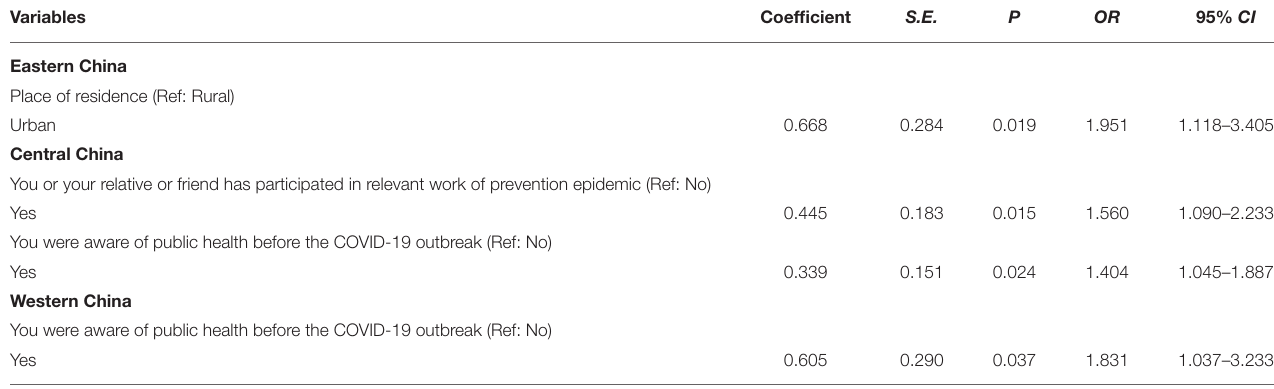
TABLE 4 | Stepwise Multivariate Logistic Regression Analysis on the Influencing Factors of Residents’ attitudes of developing public health professionals. Variables